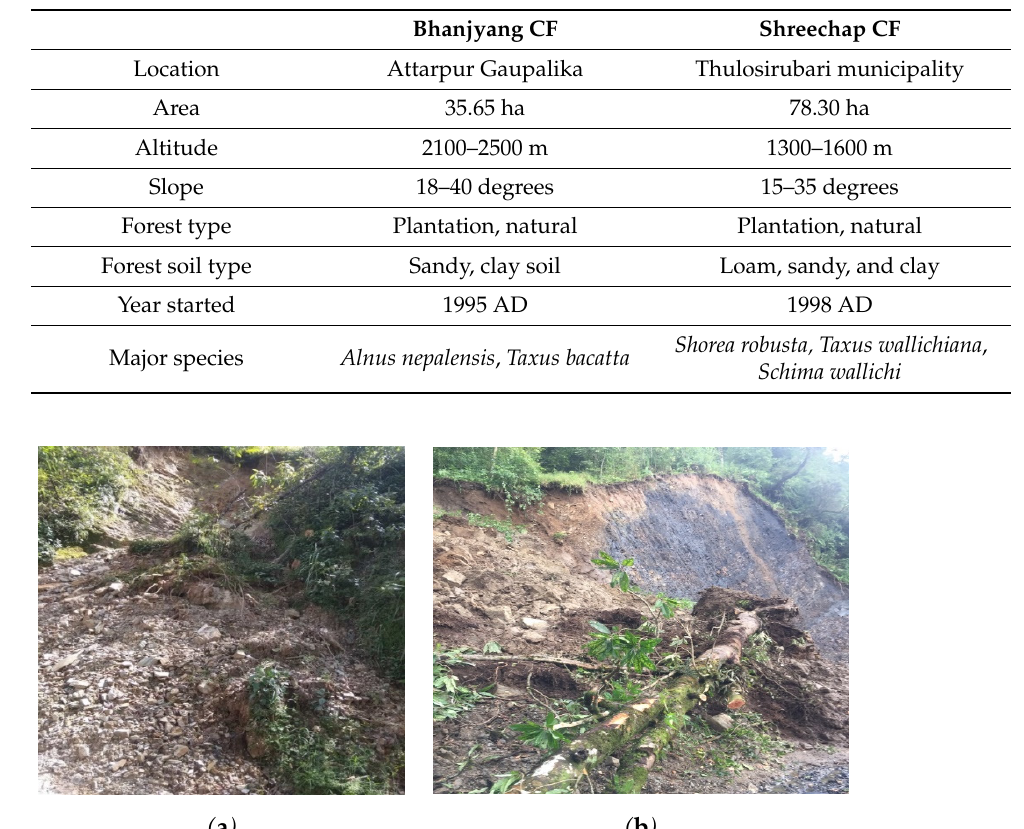
Figure 2. The figure ( a , b ) shows the forest situation of the studied CF due to landslide after the 2015